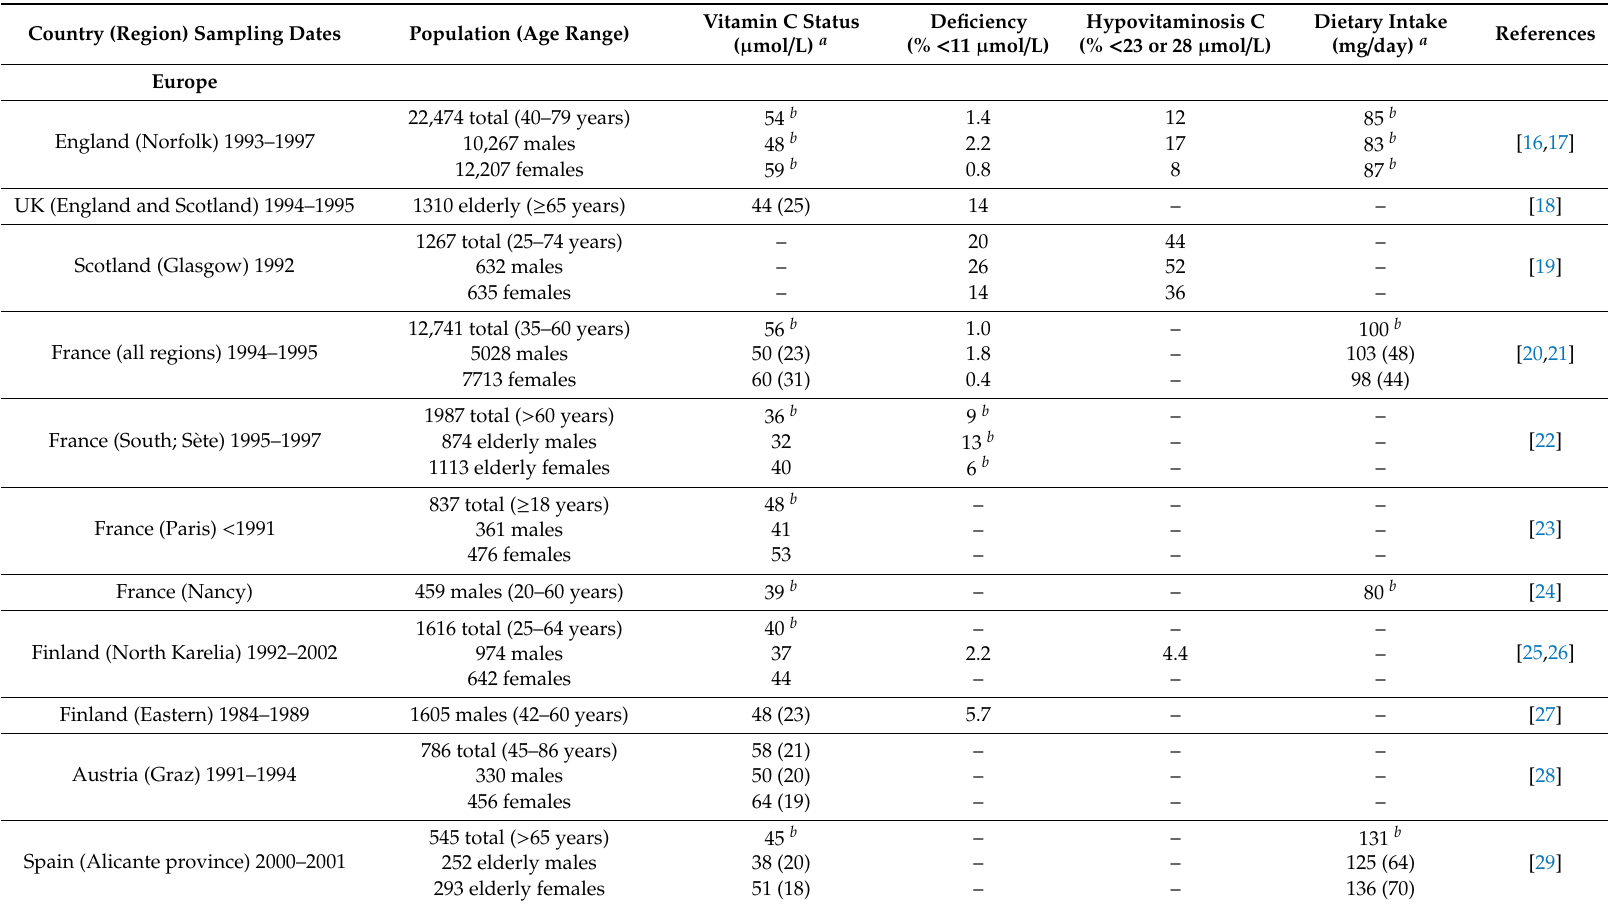
Table 1. Vitamin C status and prevalence of deficiency and hypovitaminosis C in adults from high-income